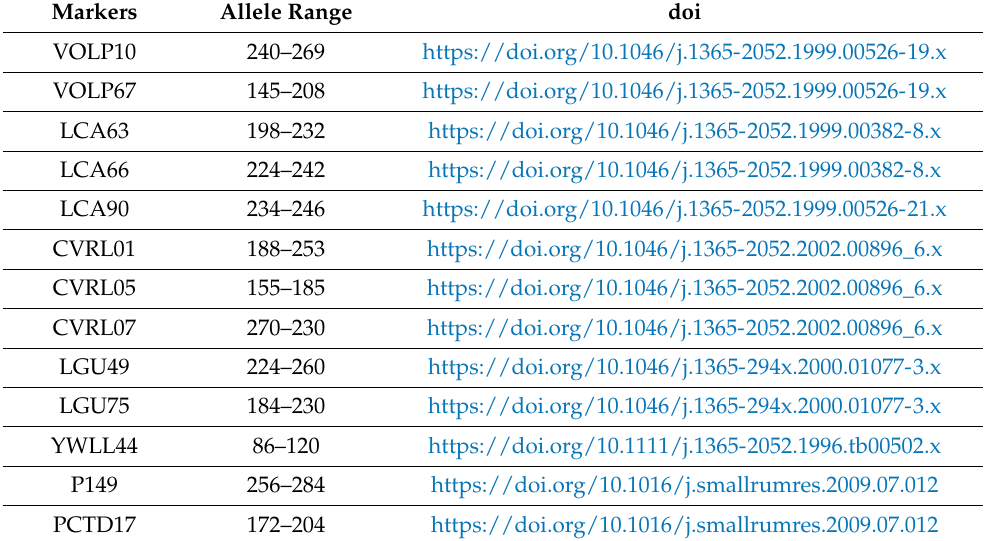
Table 1. Characteristics of 13 microsatellite loci for Camelus dromedarius .